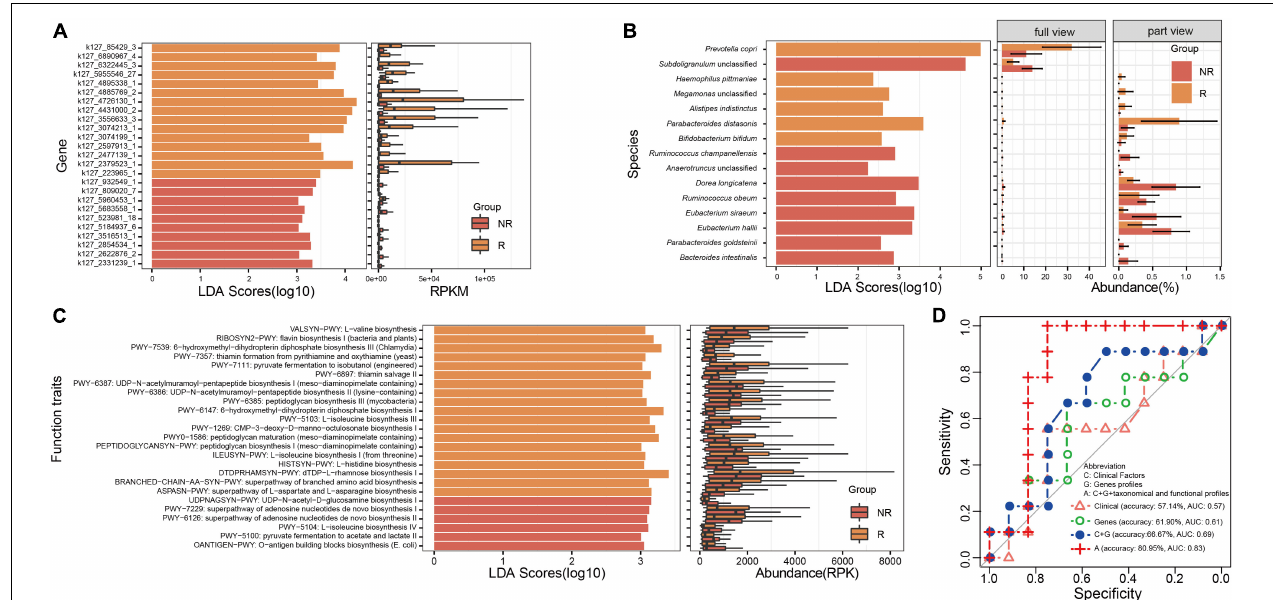
FIGURE 3 | Analysis of biomarkers and the construction of models for distinguishing the samples of the R and NR groups. (A) Gene biomarkers involved in methotrexate (MTX) metabolism, (B) taxonomical biomarkers at the species level, and (C) functional biomarkers identified between the R and NR groups. (D) Models were built using the random forest algorithm and verified; the profile of genes involved in MTX metabolism is an important feature that should be used to predict host response to